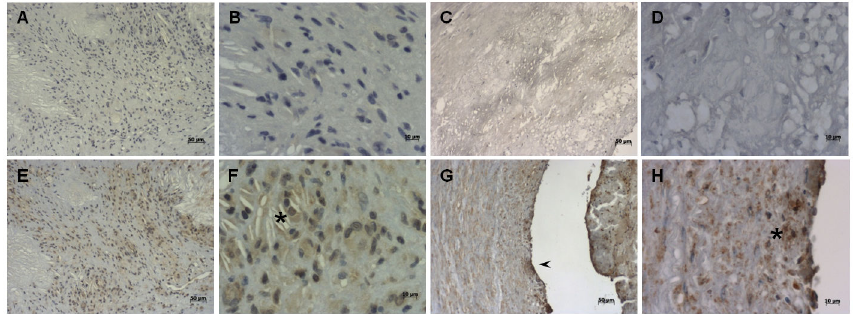
Figure 2. Infiltrating cells of the intima in coronary and carotid plaques are CD100 positive. CD100 labeling (E-H) and negative controls (A-D) in artery tissue sections of carotid plaques (A, B, E, F) and coronary plaques (C, D, G, H) by immunohistochemistry. Positive CD100 staining was observed only in preserved endothelium (arrowhead), and in infiltrating cells in the intima (asterisks). Scale bars: 10µm ( A , E , C and G ), and 50µm ( B , F , D and H ).